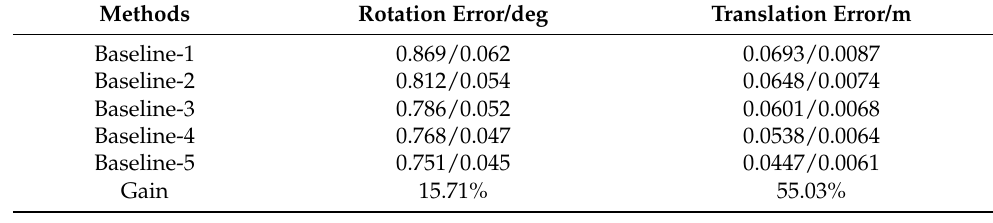
Table 3. Average and standard deviation of rotation and translation errors for five baseline methods in the validation dataset. Gain of the average calibration error is also provided.